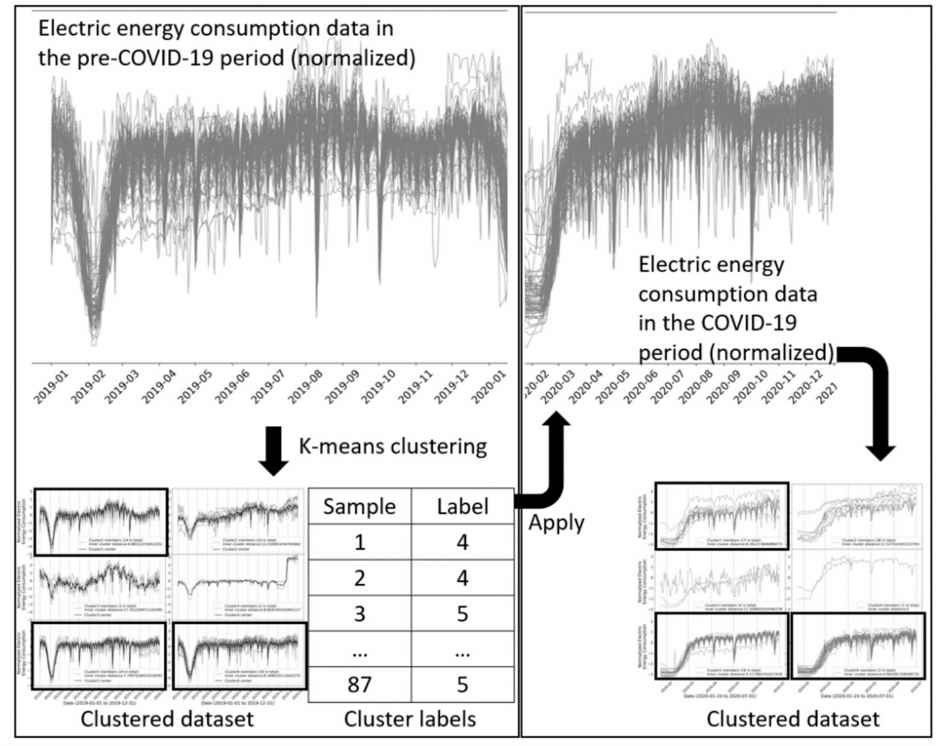
Figure 8. Schematic diagram of the clustering of the COVID-19 dataset by using the pre-COVID-19 cluster